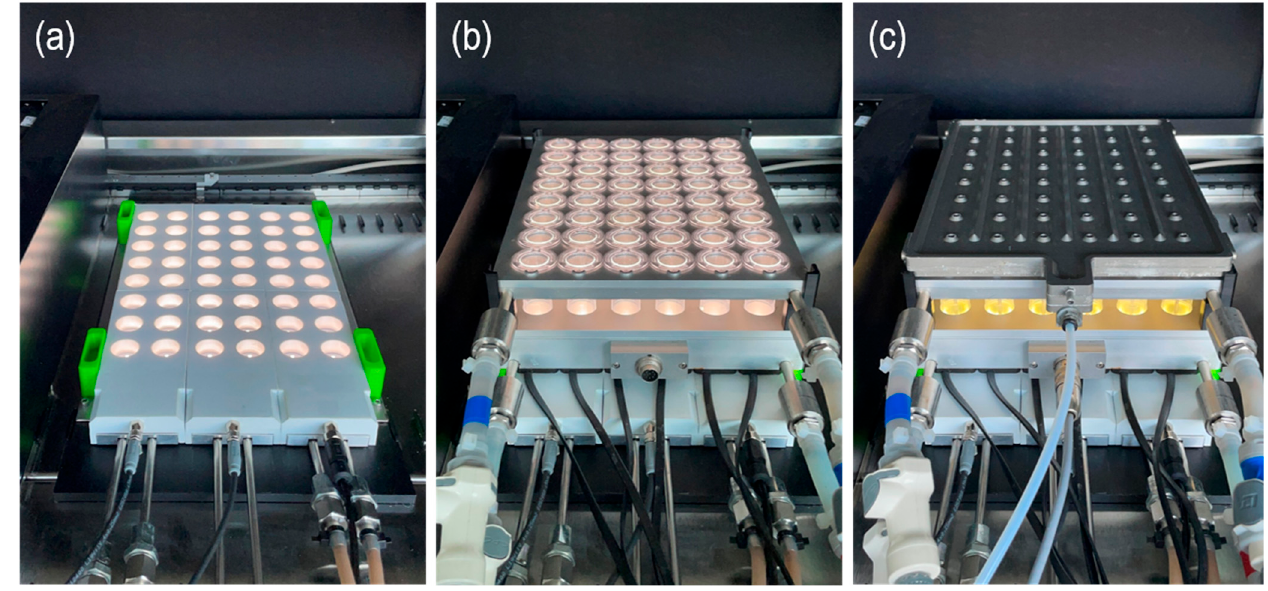
Figure 4. ( a ) Photograph showing three illumination modules on the deck of the LHS. LED illumi- nation is switched on. ( b ) Photograph showing the bioreaction unit (bioREACTOR48, 2mag AG, Munich, Germany) with 48 single-use bioreactors positioned above the three illumination modules.